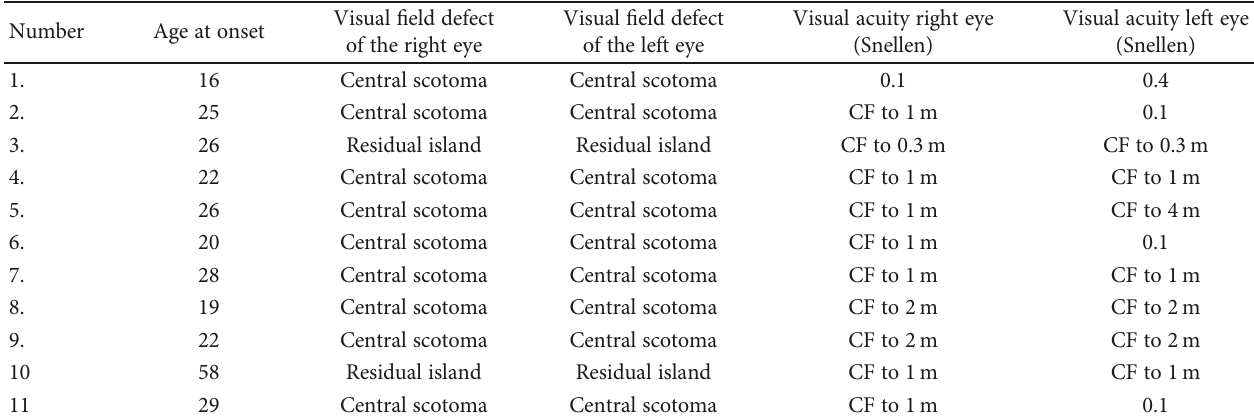
Table 1: Gender, age, visual fi eld defect obtained using semi-automated kinetic perimetry (SKP), and visual acuity of patients with diagnosed Leber hereditary optic neuropathyCF-counting fi